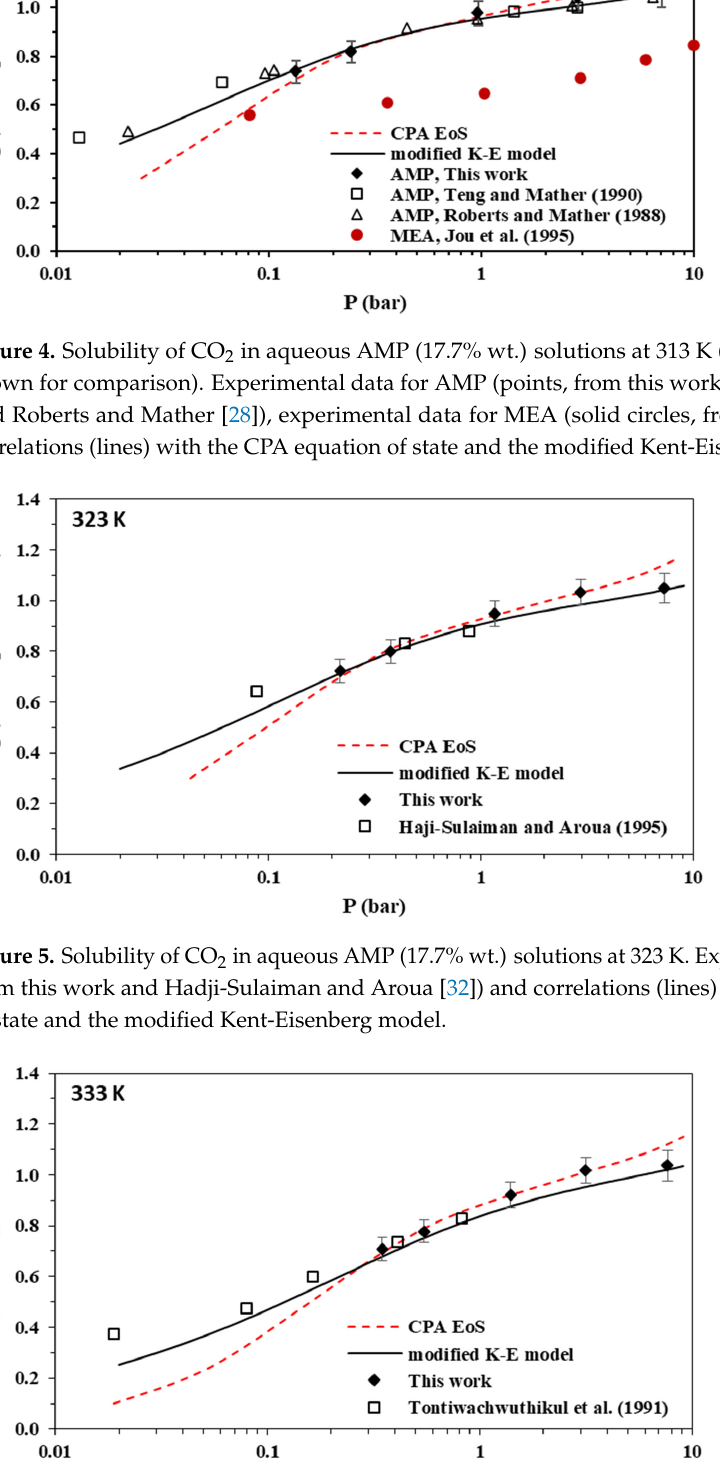
Figure 7. Solubility of CO 2 in aqueous MAPA (30.0% wt.) solutions at 298 K. Experimental data (points, from this work) and correlations (lines) with the CPA equation of state and the modified Kent–Eisenberg model.